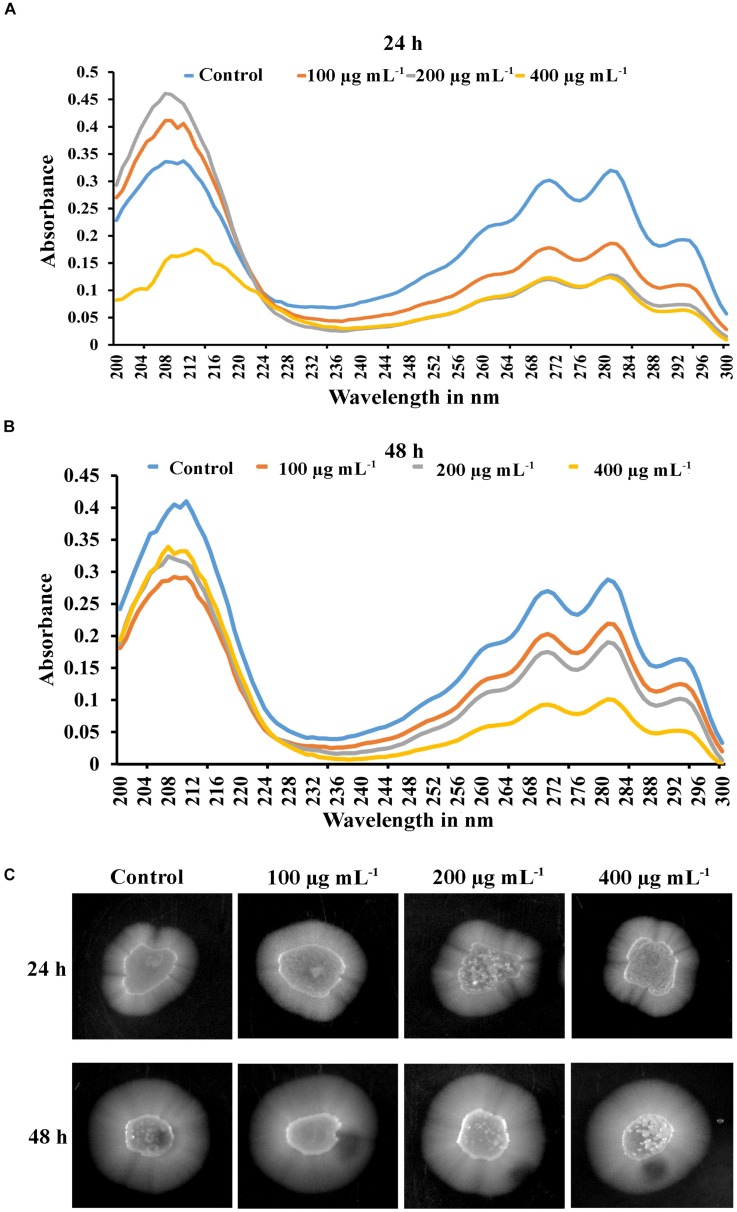
Inhibitory effect of PA (100, 200, and 400 μg mL−1) on ergosterol biosynthesis of C. tropicalis after 24 h (A) and 48 h (B) treatment. Ergosterol was extracted by n-heptane and unique sterol spectral profiles of C. albicans was measured in the range between 240 and 300 nm. (C) PA induced C. tropicalis hyphae on spider agar medium with increasing concentrations on both the time points.